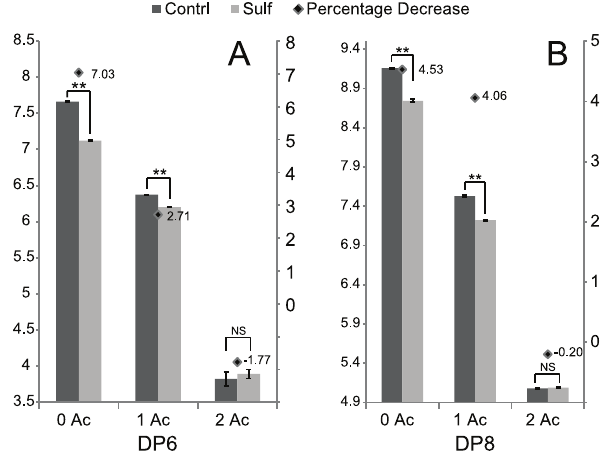
Figure 2. Changes of sulfate degree before and after HSulf2 digestion of HS oligosaccharides. A. HS DP6 sulfated changes for 0 Ac, 1 Ac and 2 Ac series. B. HS DP6 sulfated changes for 0 Ac, 1 Ac and 2 Ac series. Left Y-axis denotes the sulfation degree represented as the average sulfate number per disaccharide. Right Y-axis denotes the decrease in sulfate degree after HSulf2 digestion in percentage. Data significance was calculated by two-tailed Student’s t test, with ** denoting p , 0.01 and * denoting p , 0.05. NS means difference not significant.